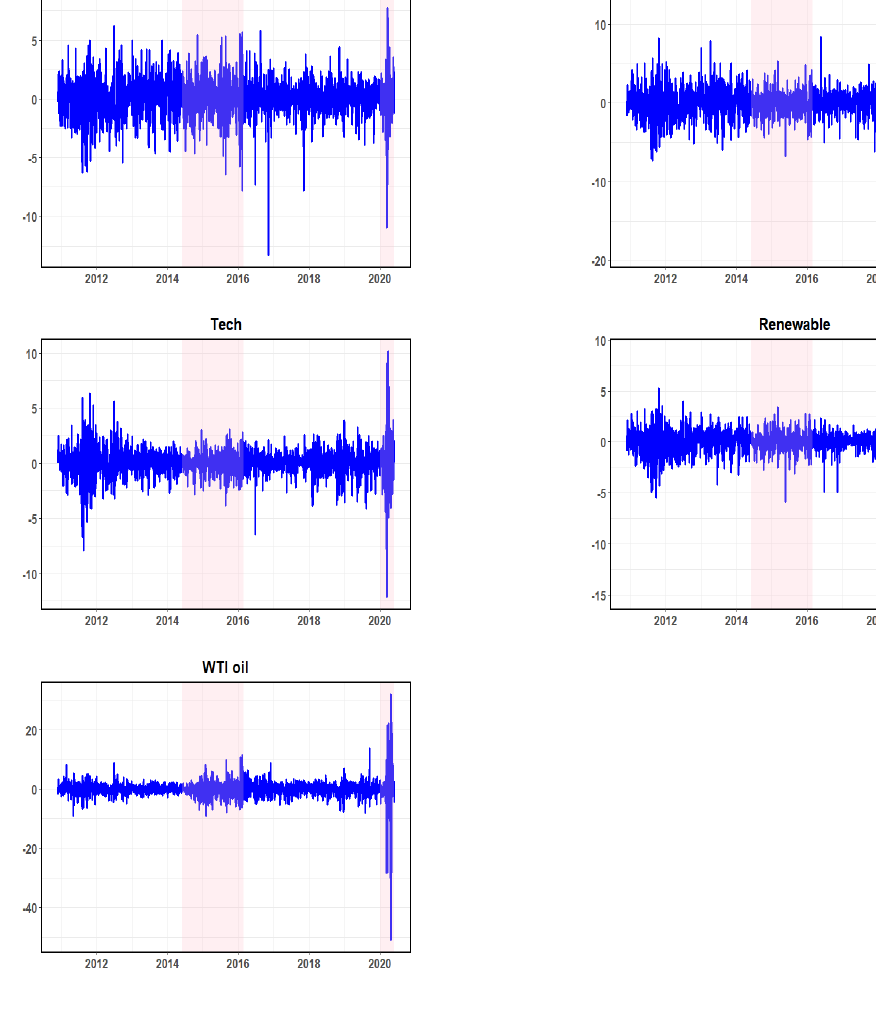
Figure 1. Time series plot of daily returns. The shaded area denotes the period of oil price drop